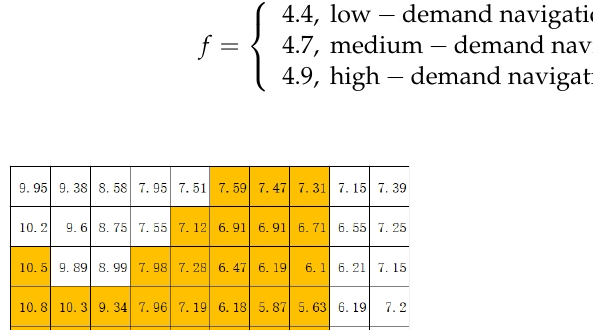
Figure 4. Part of scores in each grid of the map.